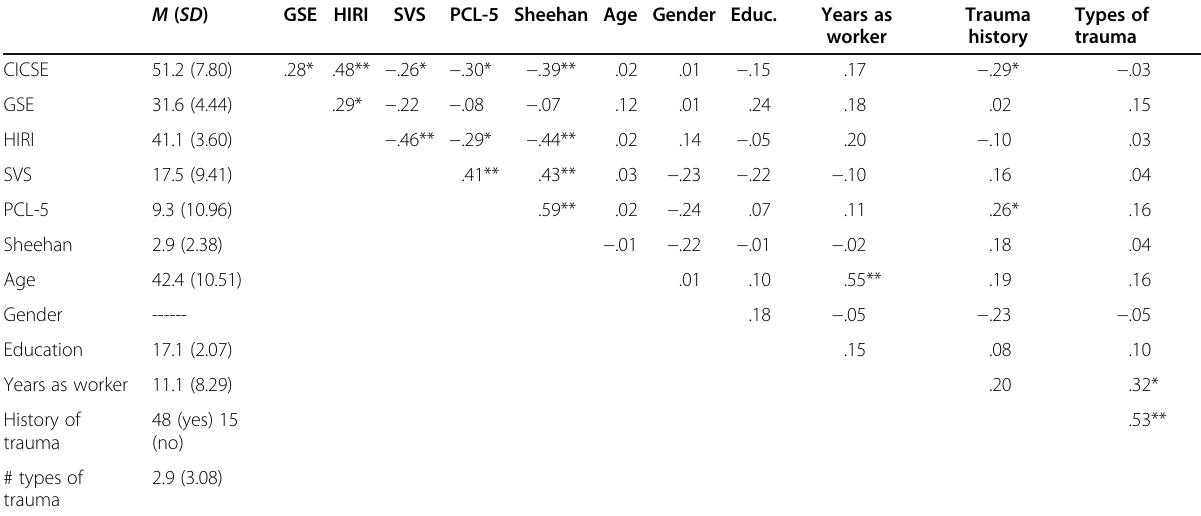
Table 2 Correlations between key study variables and demographic variables at time